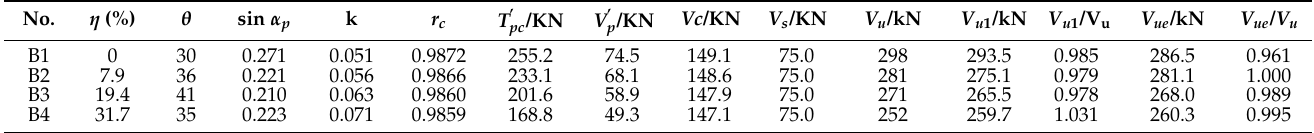
Table 5. Comparison between test results and theoretical calculation results of